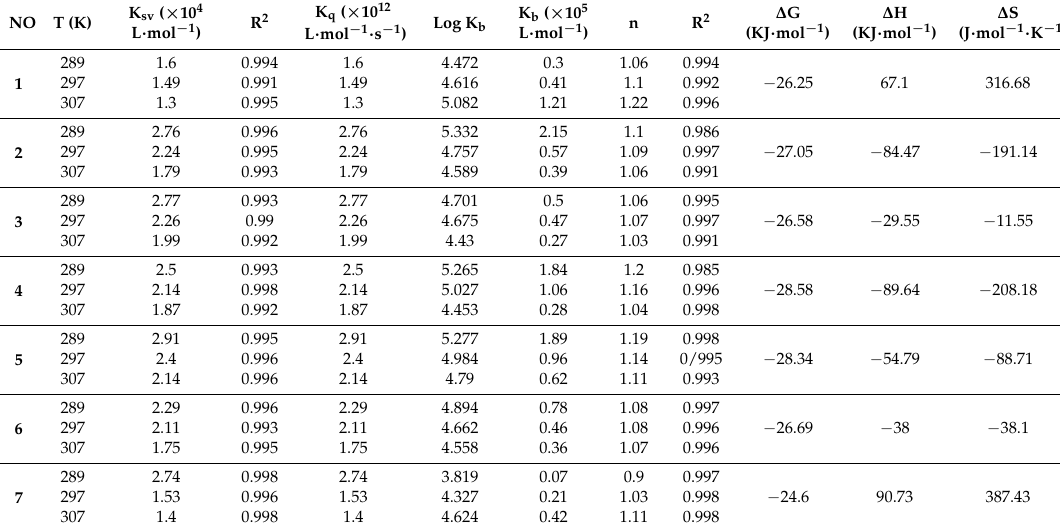
Table 3. Binding and thermodynamic parameters for the interaction between compounds 1 – 7 and BSA at different temperatures, pH =